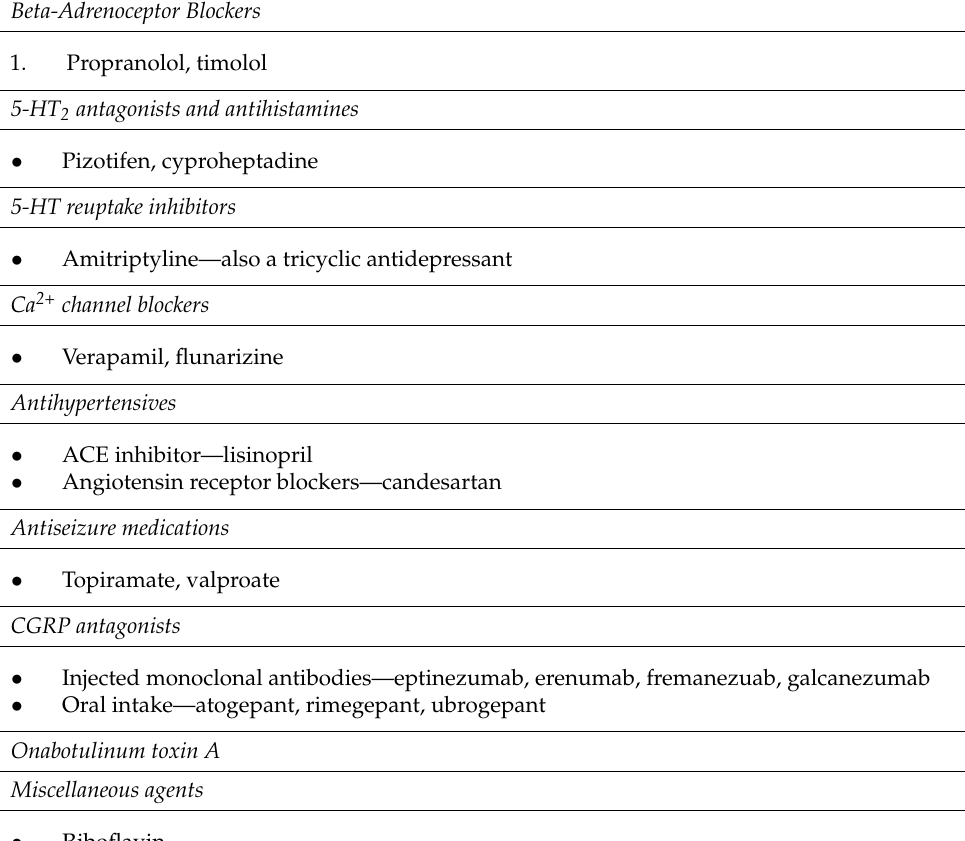
Table 2. Main drugs currently used in migraine